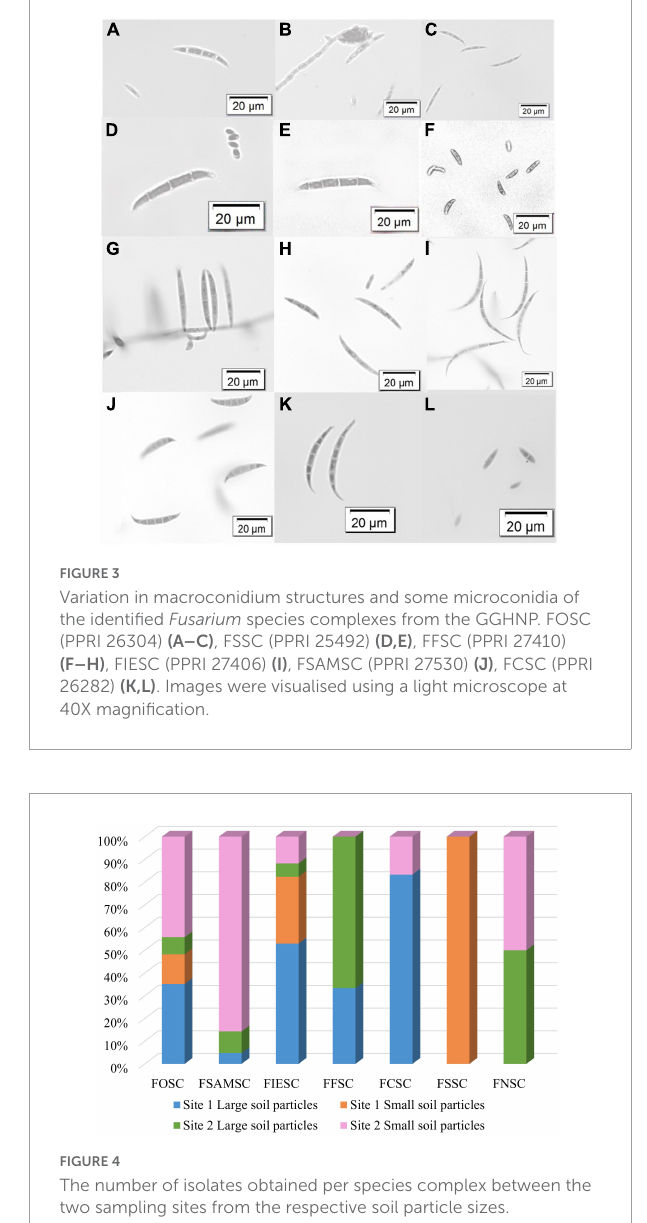
FCSC isolates were identical to each other but differed between the respective databases as either FCSC MLST 5-a and MLST 2-a ( Table 6 ). The F. chlamydosporum clade grouped basal